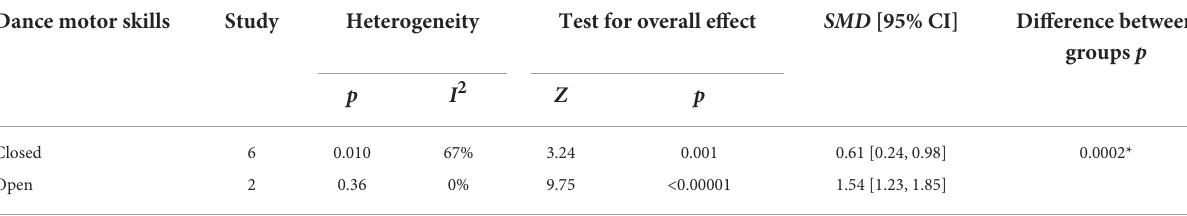
TABLE 4 Effects of different dance motor skills on global cognition. Dance motor skills